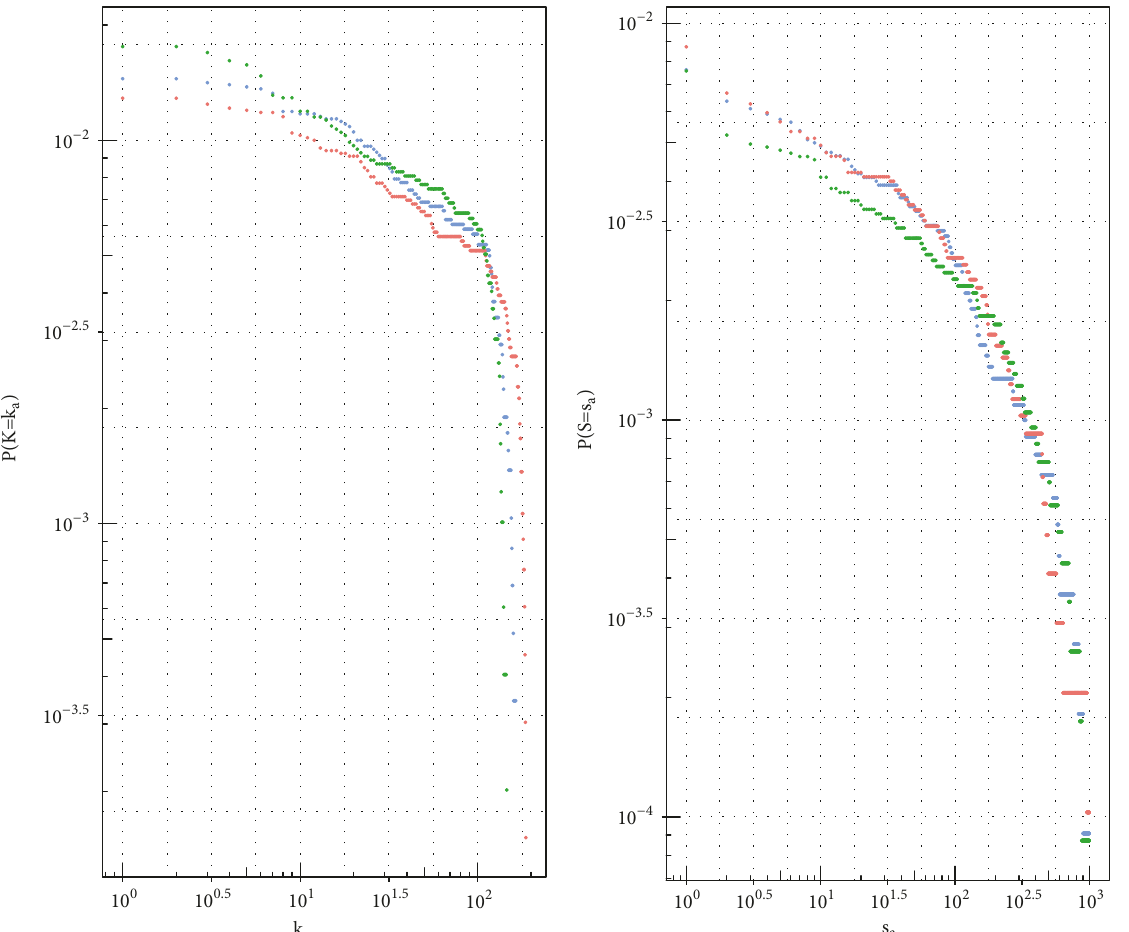
Figure 1: Degree (k a ) and Strength (s a ) densities for stocks in the bipartite networks. Differentcolors for each period. In blue, precrisis period from January to June 2008. In red, crisis period from June 2008 to January 2009. In green, postcrisis period from February to June